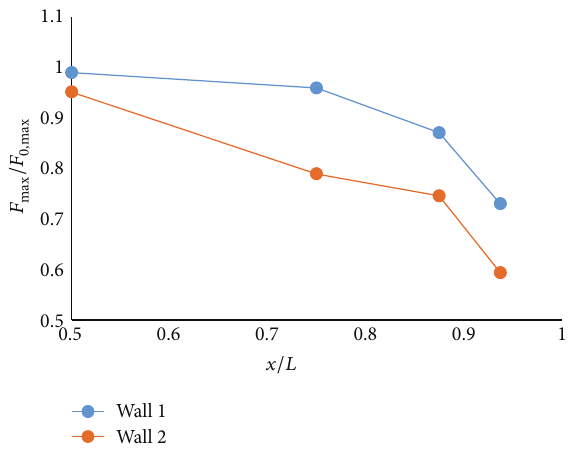
Figure 6: Maximum force as a function of wave